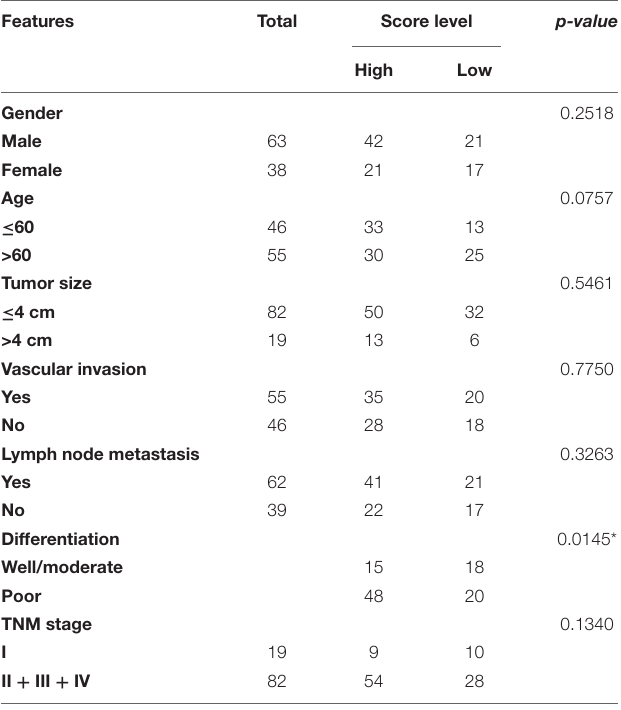
TABLE 2 | The association of the immune signature with clinicopathological characteristics in Ruijin cohort.